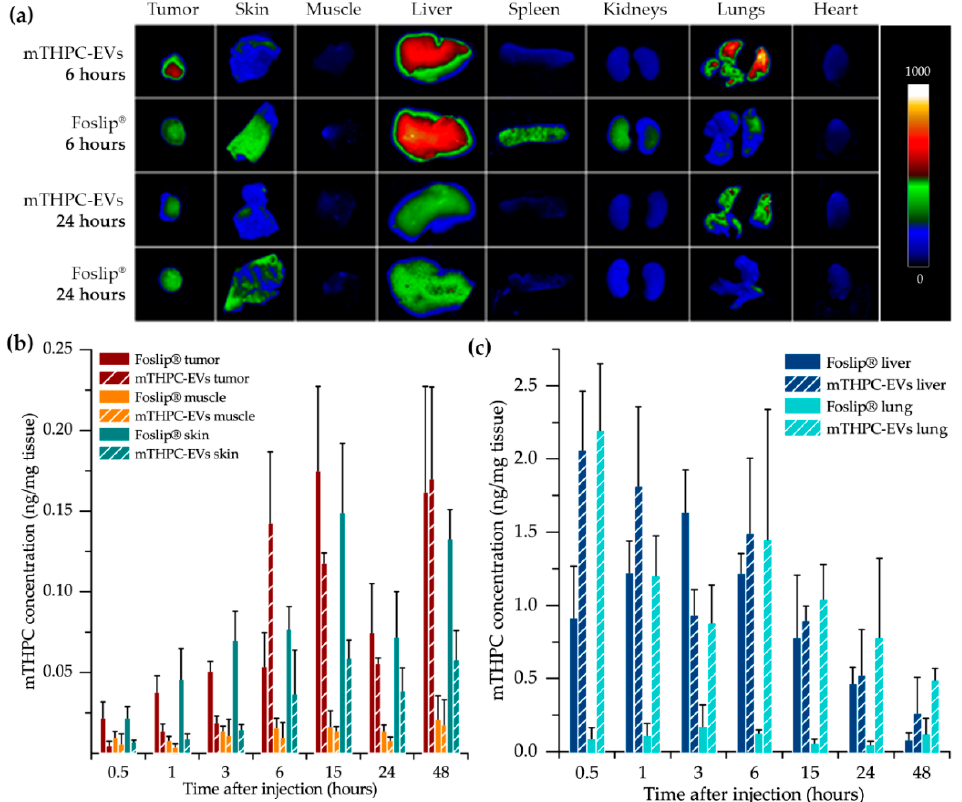
Figure 3. Kinetics of mTHPC biodistribution in selected organs. ( a ) Fluorescence imaging was obtained 6 and 24 h after injection of Foslip ® or mTHPC-EVs. The concentration of mTHPC in selected tissues, obtained after chemical extraction, is expressed in function of time after intravenous injection: ( b ) tumor, skin and muscle; ( c ) liver and lungs.